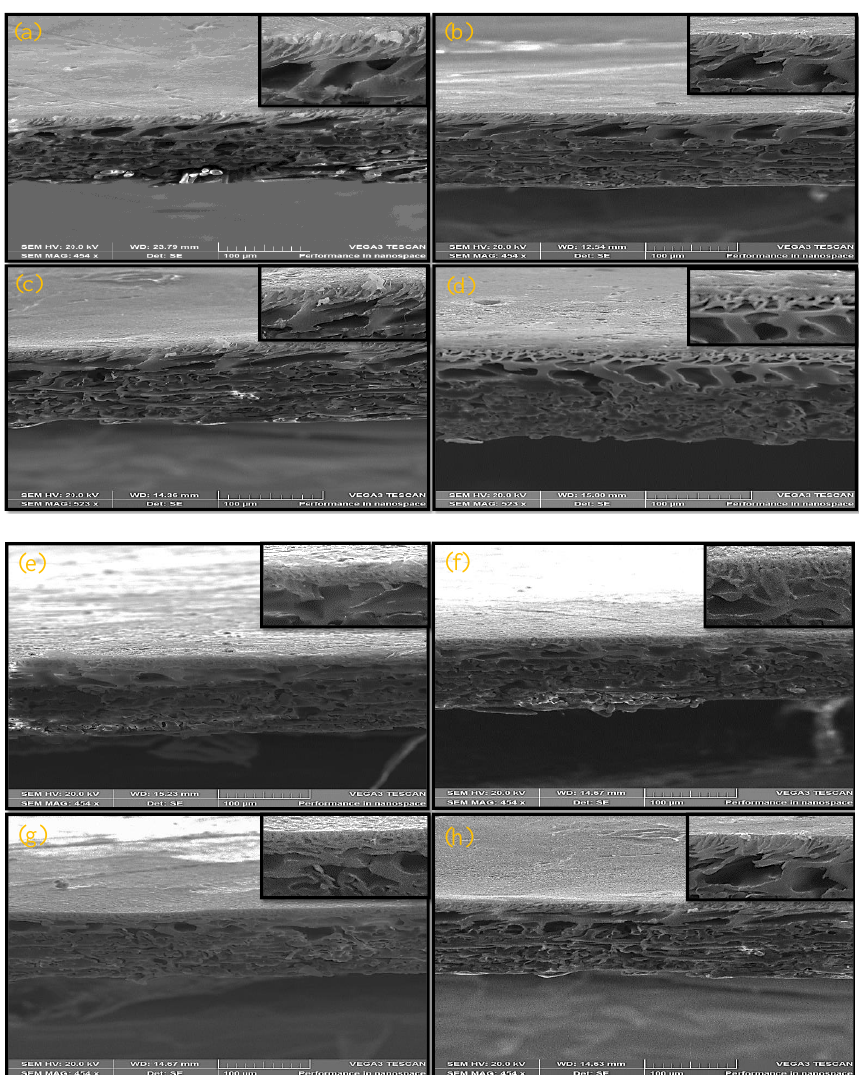
Figure 10. Cross sectional images of ( a ) M0, ( b ) M1, ( c ) M2, ( d ) M3, ( e ) M4, ( f ) M5, ( g ) M6 and ( h ) M7. Inserts are expansions of the regions.